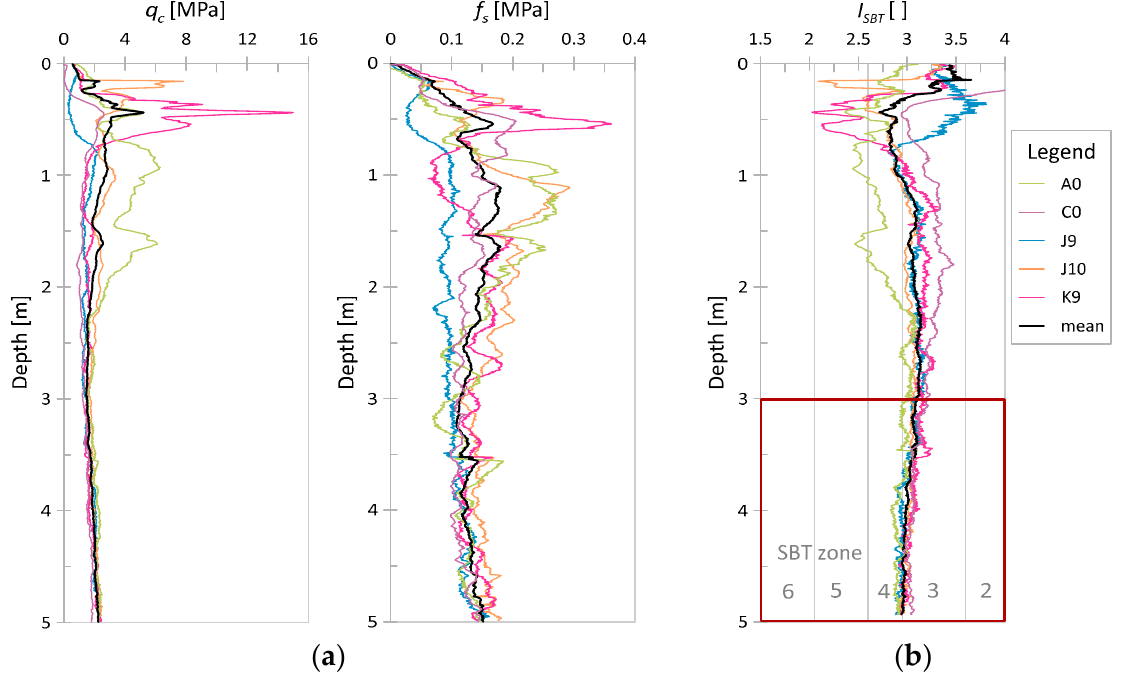
Figure 5. Results of five CPTs performed in Keswick clay [43]; ( a ) cone resistance q c and sleeve friction f s vs. depth; ( b ) nonnormalized SBT index ( I SBT ) vs. depth.